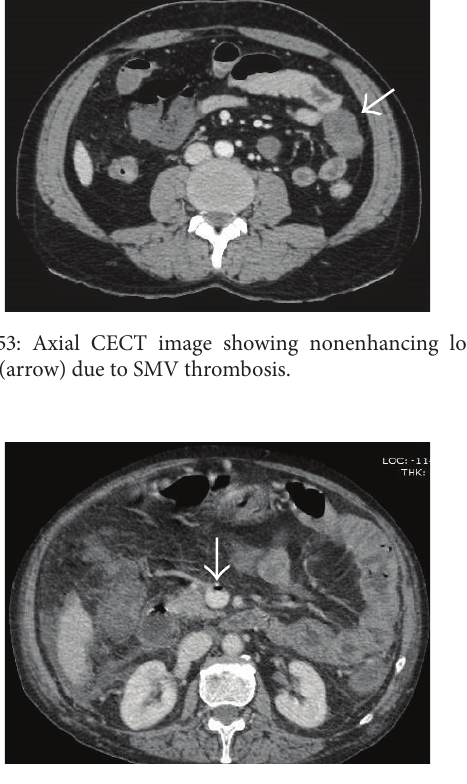
Figure 54: Axial CECT image showing nondependent focus of portal venous gas (arrow) with mesenteric stranding and